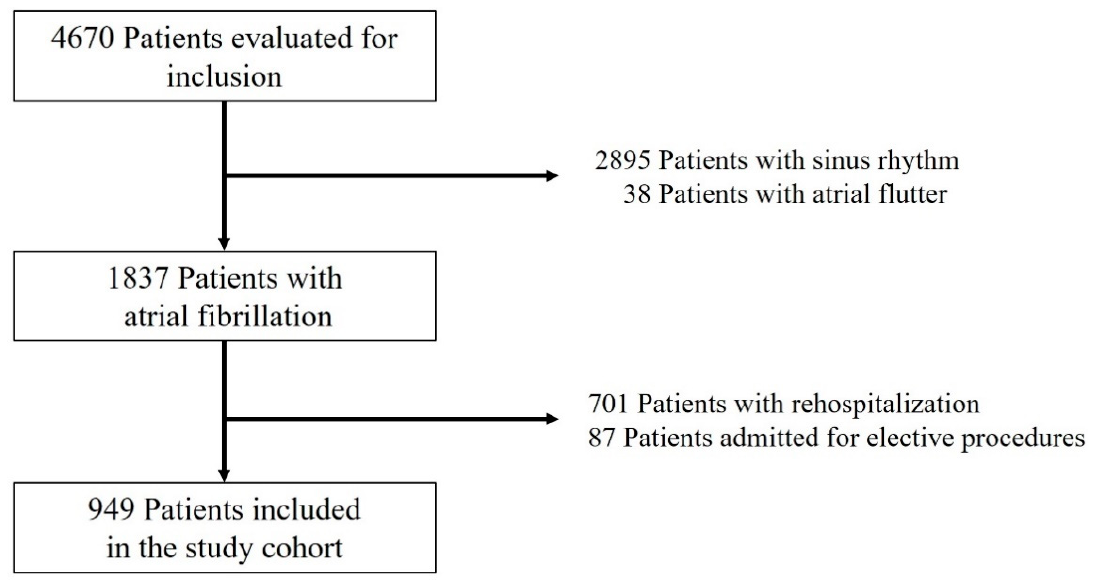
Figure 1. PRISMA consort flow diagram of the study. Common comorbidities included ischemic heart disease (IHD) (32.4%), arterial hy- pertension (80.6%), diabetes mellitus (31.3%), dyslipidemia (68.0%), obesity (31.1%) and chronic kidney disease (36.0%). A total of 14.5% of patients had a history of stroke or transient ischemic attack (TIA). The median CHA2DS2-VASc score was 4 and HAS-BLED 1. Of the three types of AF, permanent AF was prevalent (44.8%) (Table